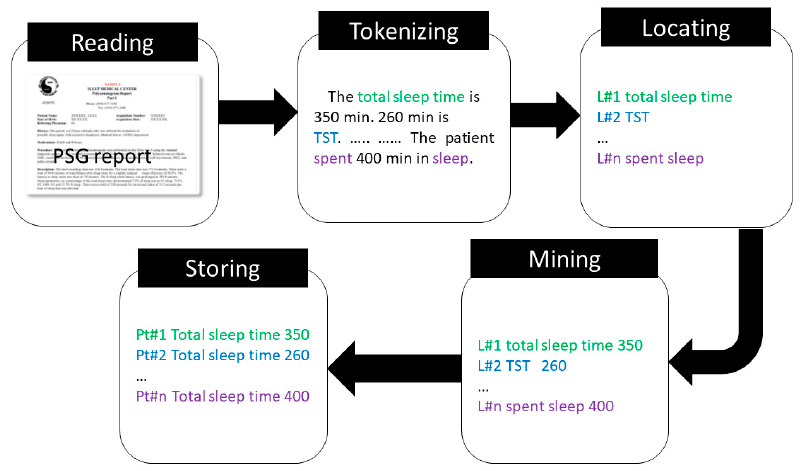
Figure 1. An NLP flow diagram to extract sleep parameters from the PSG